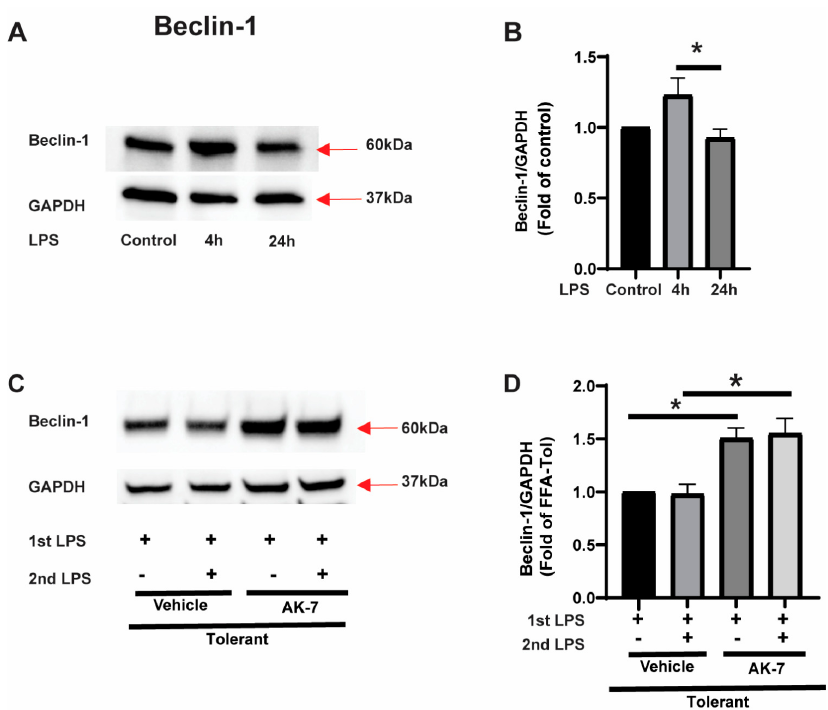
Figure 2. Beclin-1 expression in sensitive and tolerant macrophages. Stearic acid (free fatty acid: FFA)-exposed sensitive and tolerant RAW264.7 cell macrophages (RAW) were stimulated with or without lipopolysaccharide (LPS) for 4 h or 24 h. Loading control: GAPDH. ( A ) Beclin-1 protein expression was detected in the cytosolic extract by Western blot. ( B ) Western blot image quantification using image-J software (n = 5 blots; * p < 0.05). ( C ) FFA-exposed tolerant RAW cells were treated with SIRT2 inhibitor AK-7 (25 µ M) or vehicle (DMSO; equal volume) and incubated further for 20 h and stimulated with or without LPS as indicated. Beclin-1 protein expression was detected in the cytosolic extract by Western blot ( D ). Western blot image quantification of beclin-1using image-J software (n = 5 blots; * p <